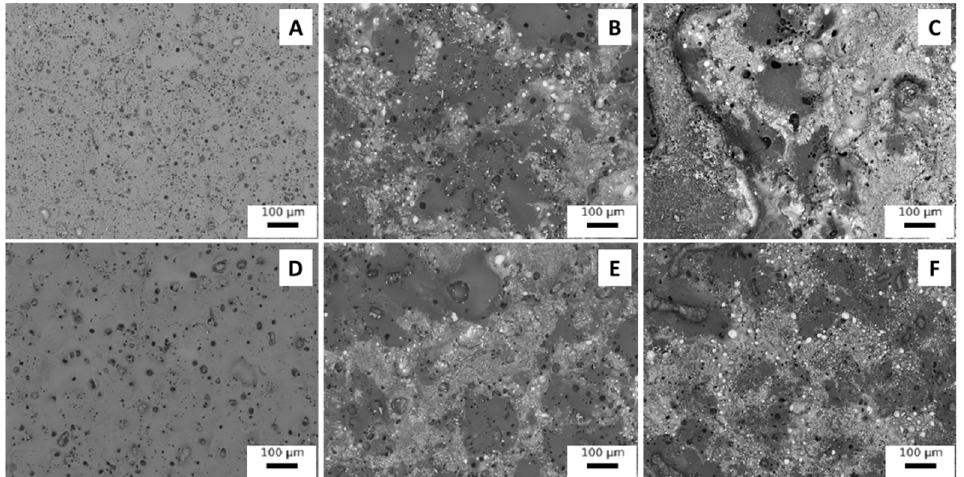
Figure 3. SEM images of the surfaces of PEO coatings obtained working at 0.5 A/cm 2 in DC mode without particles ( A ), with large particles ( B ) and with small particles ( C ), and working at 1 A/cm 2 in UPC without particles ( D ), with large particles ( E ) and with small particles ( F